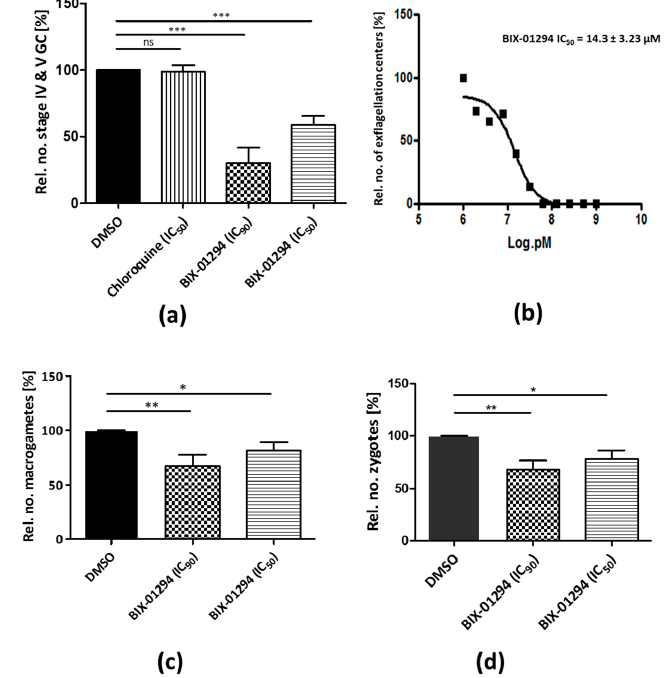
Figure 2. Effect of BIX-01294 on P. falciparum sexual development. ( a ) Effect of BIX-01294 on gametocyte (GC) development. BIX-01294 at IC 50 or IC 90 concentrations was added to stage II GC cultures for 48 h.